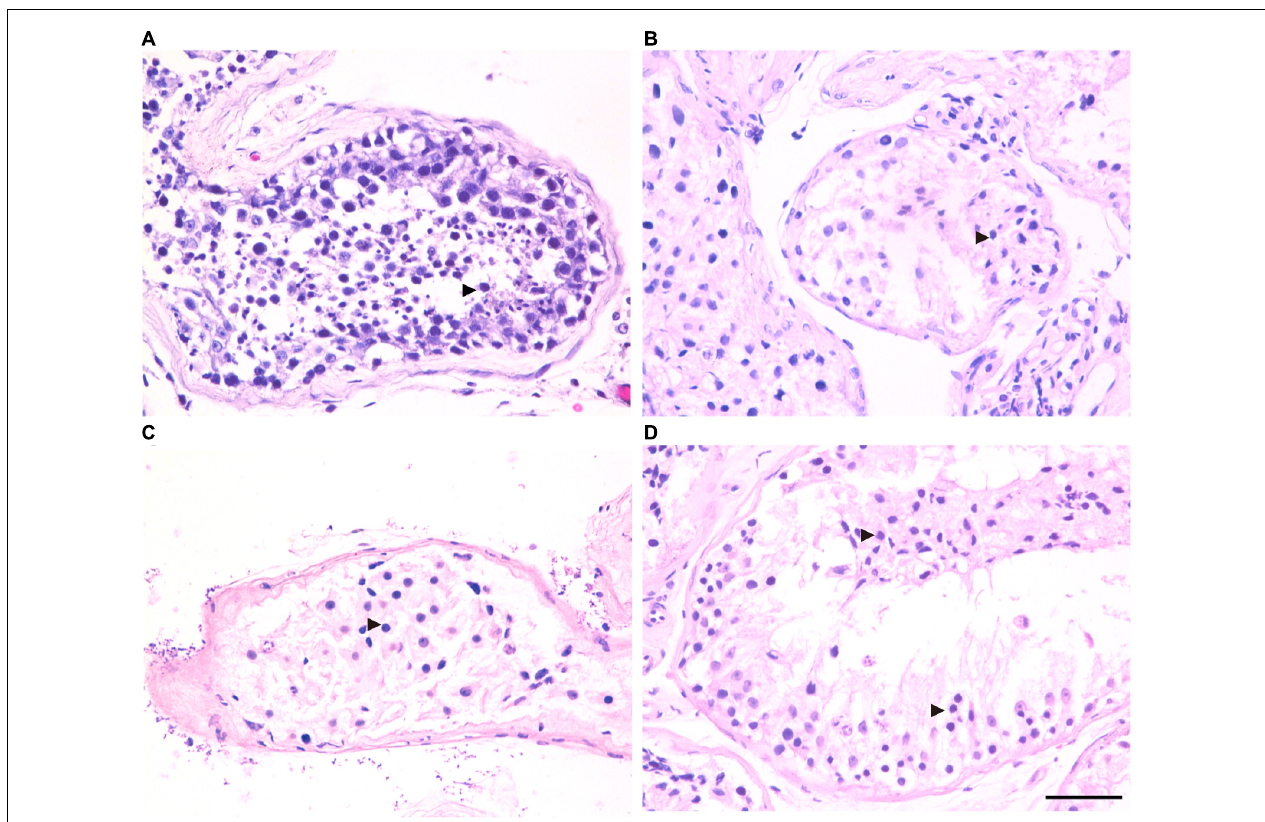
FIGURE 3 | H&E staining of cross-sections of testis in affected patients and a patient with obstructive azoospermia (OA) as positive control. (A) Hematoxylin-eosin (H&E) staining of cross-sections of testicular biopsy from the patient with OA (A) , the P5648 (B) , the P6825 (C) , 7583 (D) . Scale bars = 50 µ m in panel (D) . Black triangles indicate the spermatocytes in the